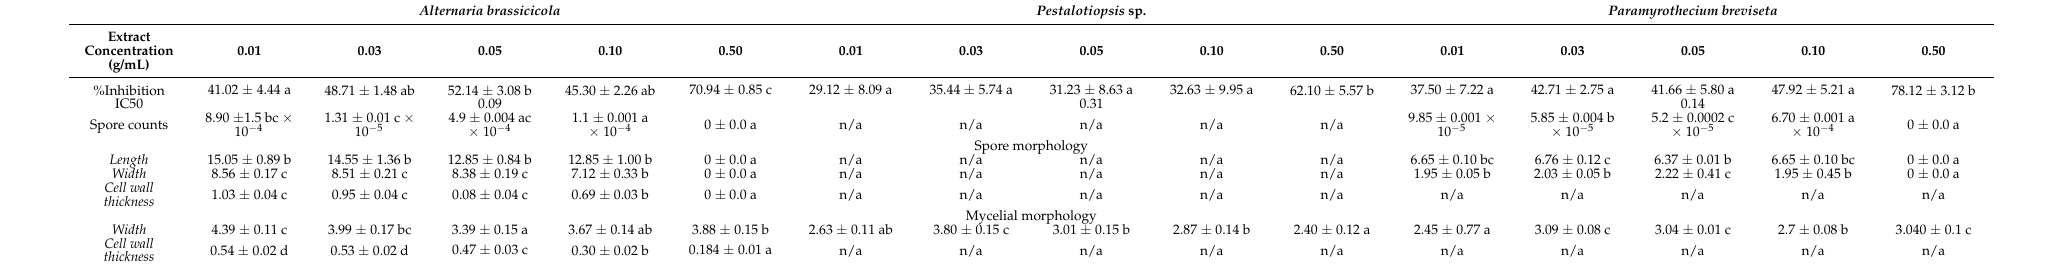
Table 4. Antifungal inhibition and morphology of the spores and